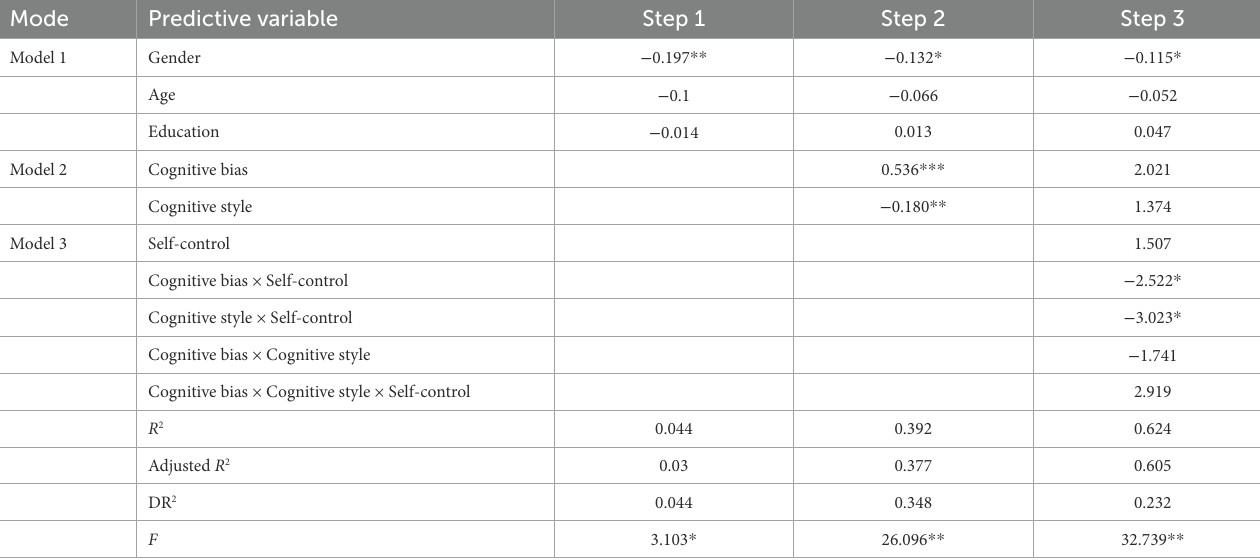
TABLE 5 Hierarchical regression analysis results of cognitive bias, cognitive style, self-control, and trait impulsivity.